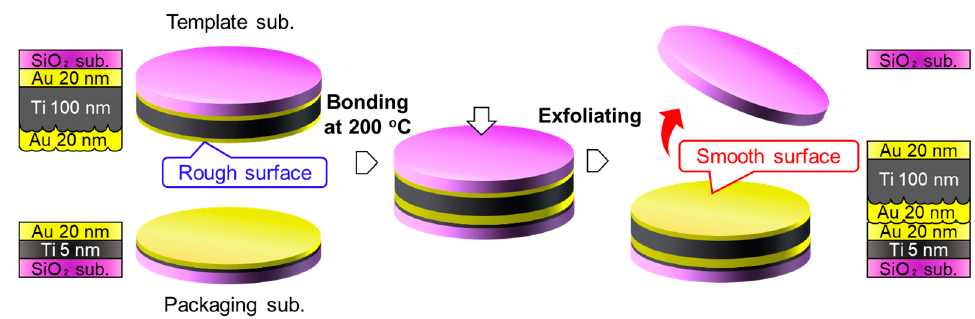
Figure 5. Second approach to transfer smooth Au/Ti/Au getter layer to packaging substrate.